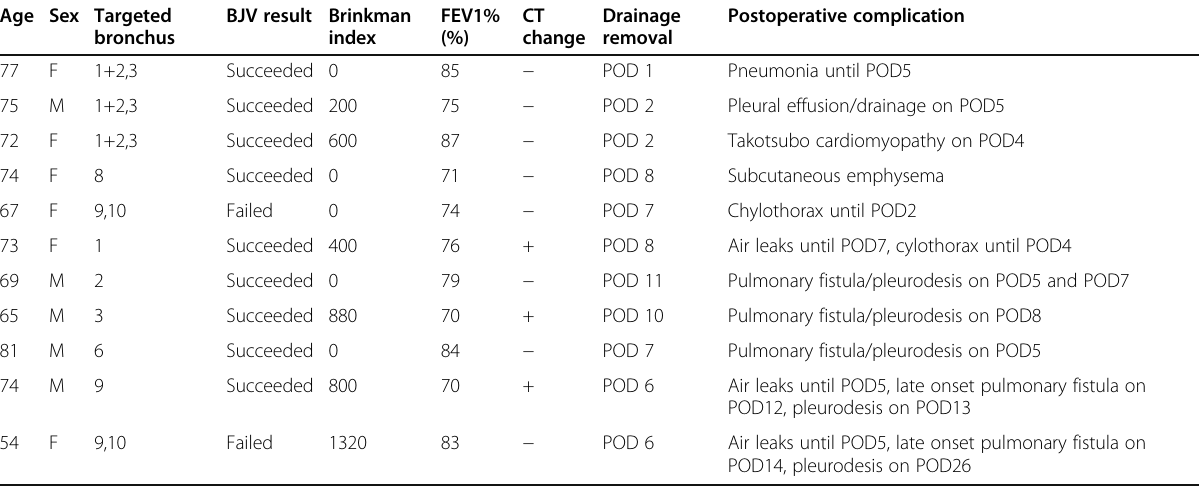
Table 2 Postoperative complication after thoracoscopic pulmonary segmentectomy with bronchoscopic jet